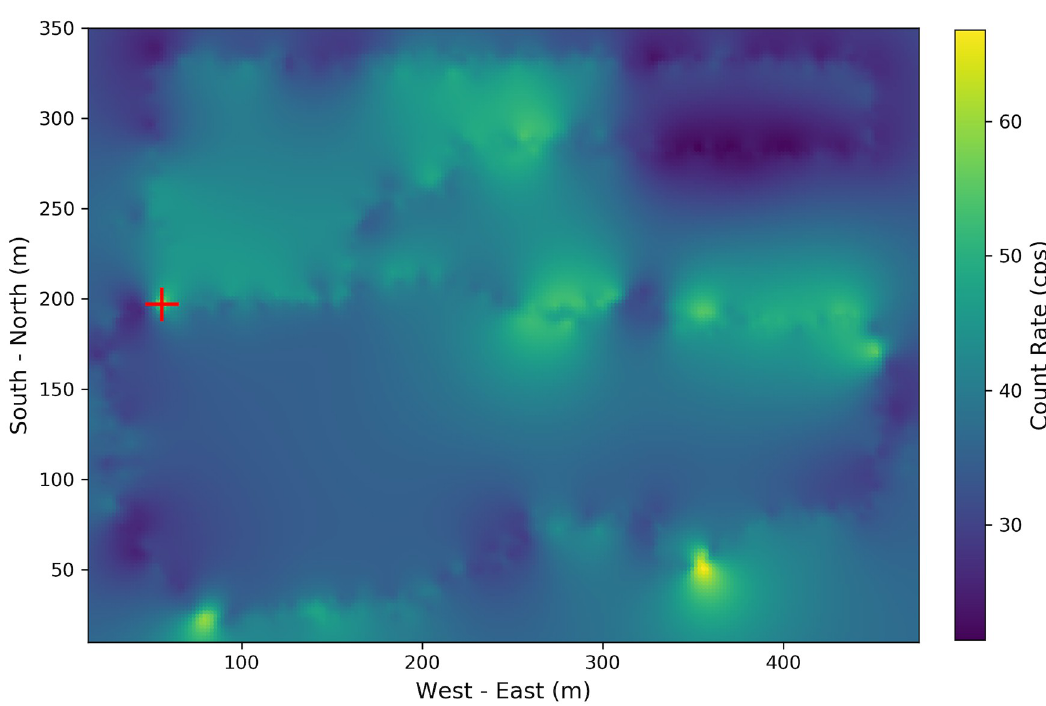
Fig 5. Poisson kriging estimation with synthetic source injection. The 100 μCi 137 Cs source is injected 1 meter away from the walking path, which is denoted using a red cross.